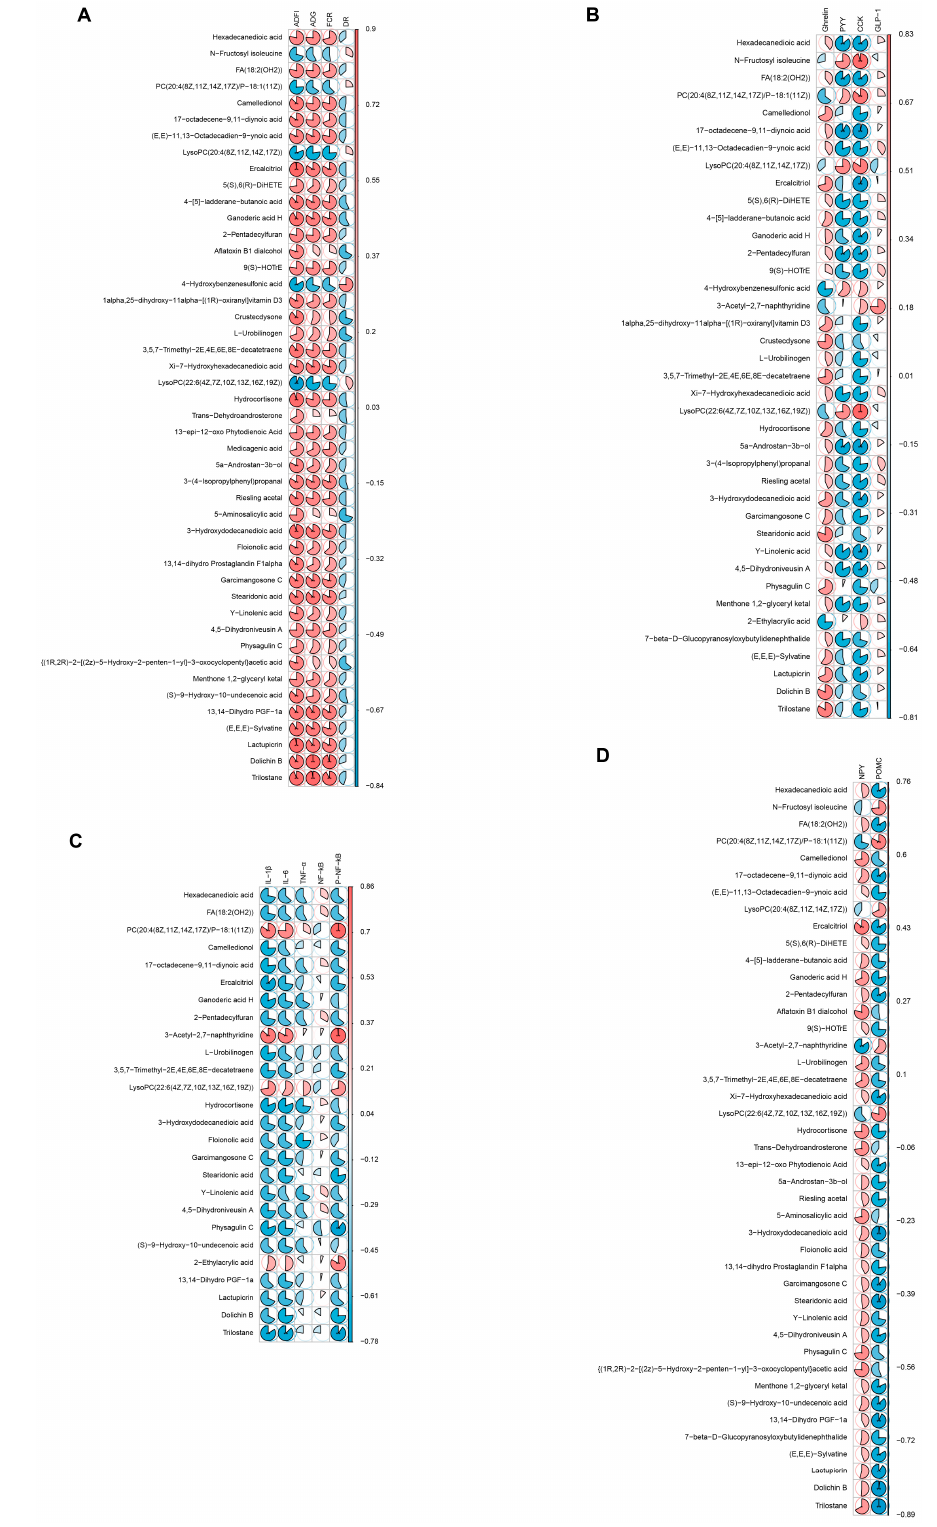
Figure 7. Correlation analysis of the plasma metabolome with growth status, plasma gut–brain hormones, inflammatory factors in the hypothalamus, and appetite-regulating proteins in the hy- pothalamus in weanling rabbits. *: 0.01 < p ≤ 0.05, **: 0.001 < p ≤